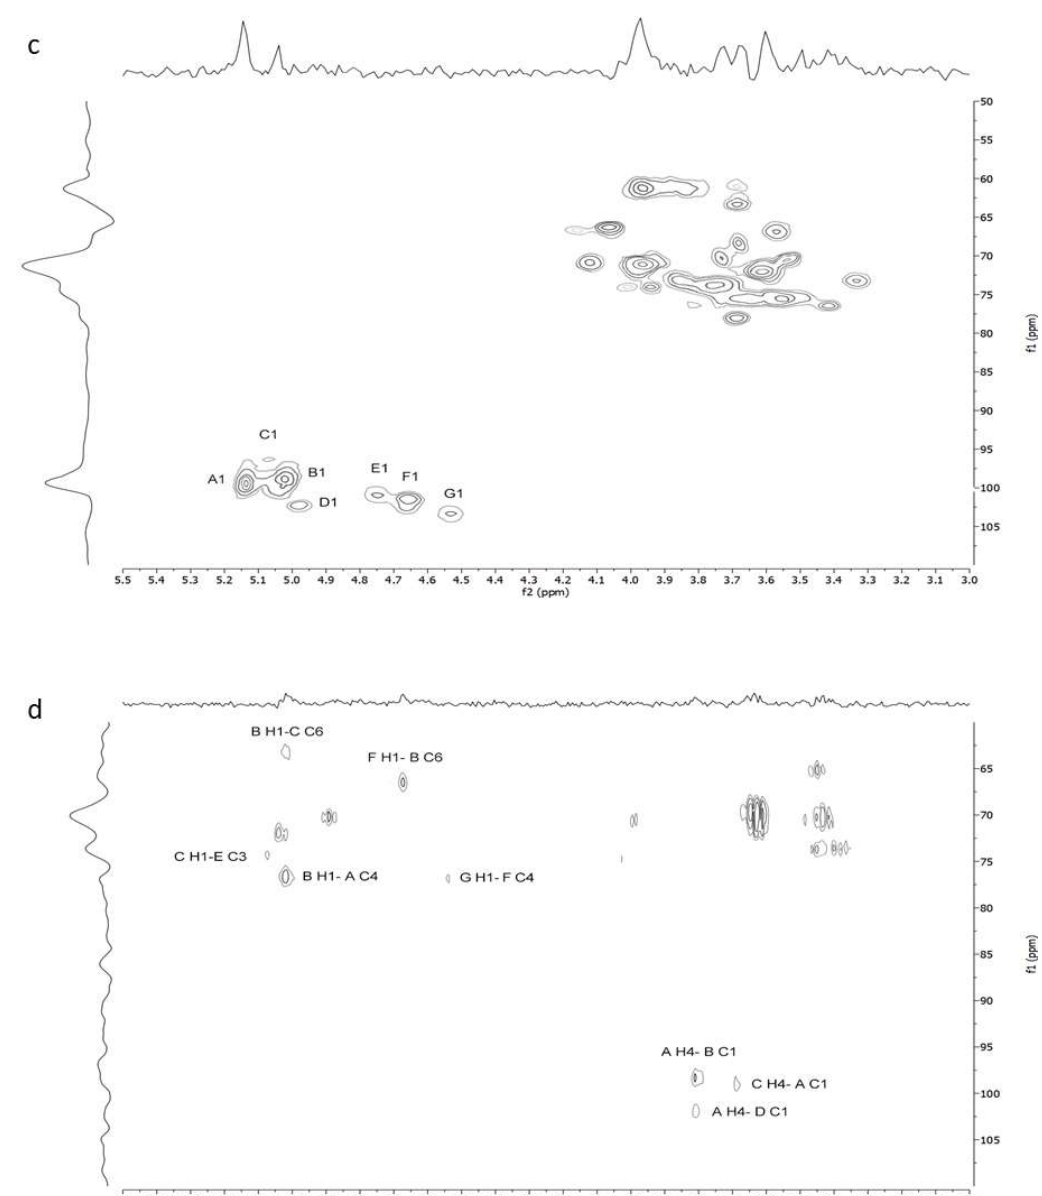
Figure 4. ( a ) 1 H NMR spectrum, ( b ) 13 C NMR spectrum, ( c ) HSQC NMR spectrum, and ( d ) HMBC NMR spectrum of polysaccharide fraction NMCP-2 recorded in D 2 O.